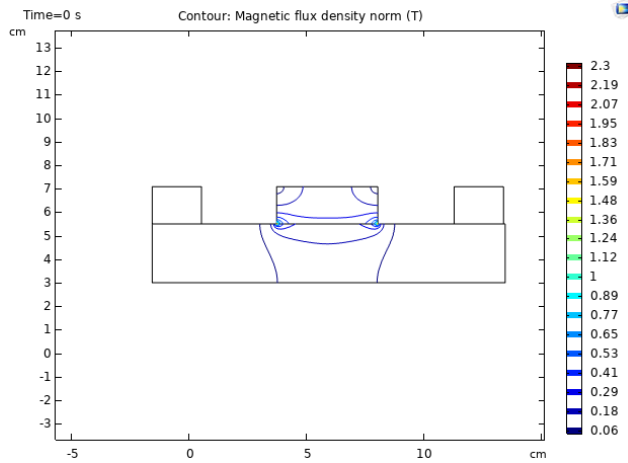
Figure 6. Magnetic flux density upon the application of the fluid flow